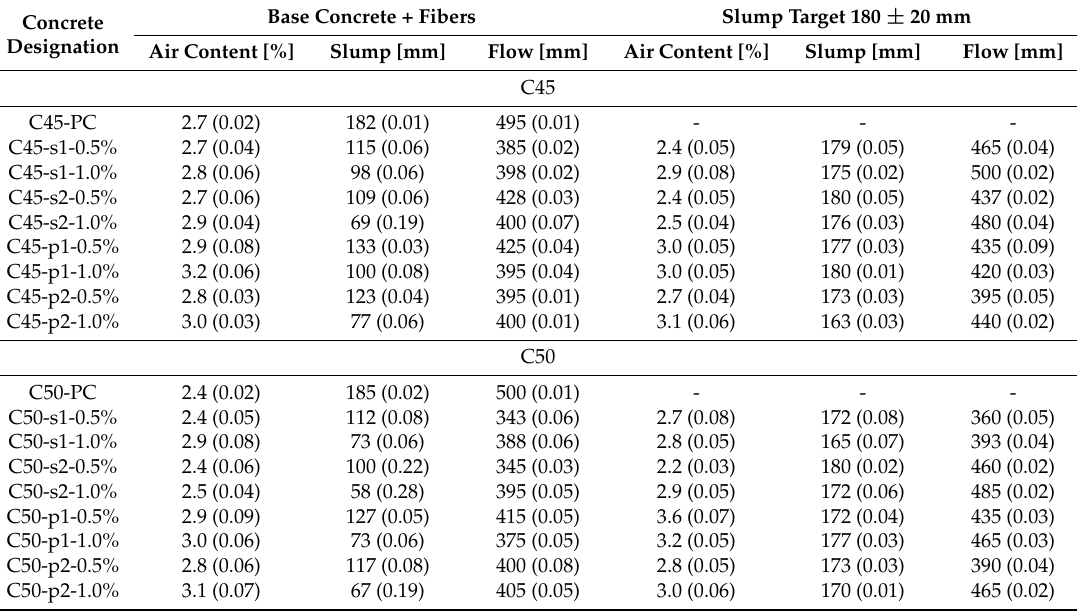
Table 4. Fresh state properties of concrete C45 and C50 (CV in